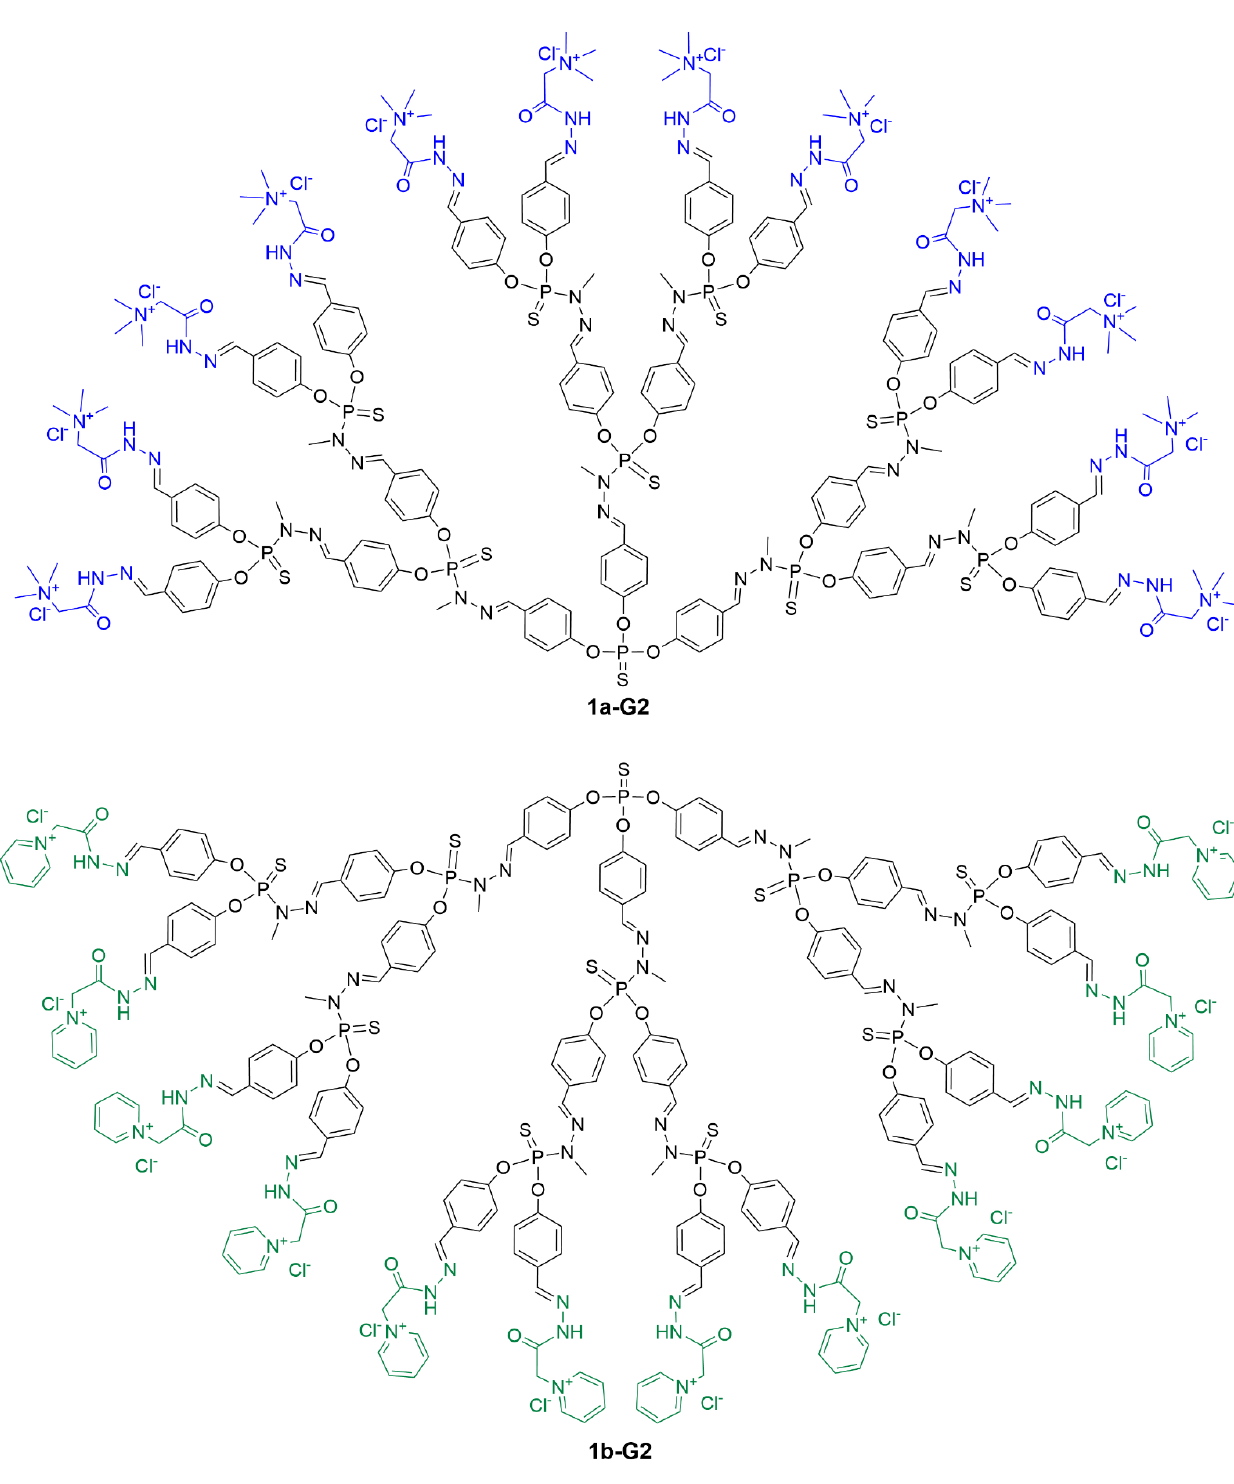
Figure 2. Full chemical structure of dendrimers 1a-G2 (functionalized with the Girard T reagent) and 1b-G2 (functionalized with the Girard P reagent).